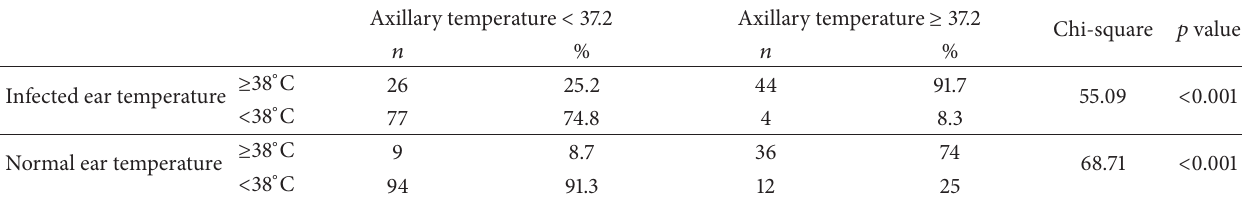
Table 2: The associations between axillary and tympanic temperatures in patients with acute otitis